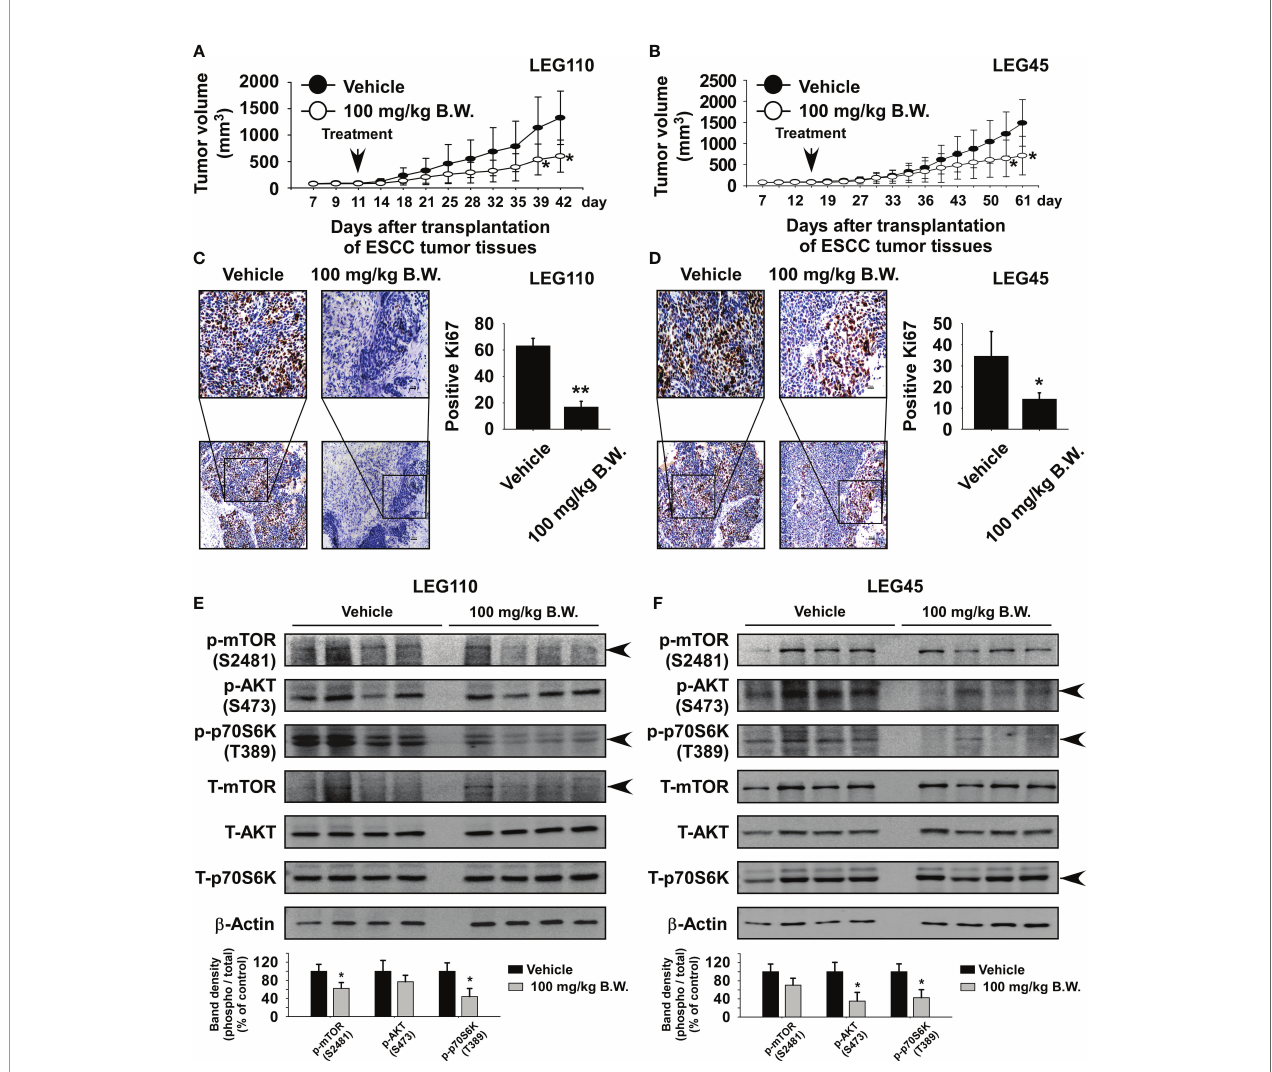
FIGURE 6 | Ethyl ferulate reduces esophageal squamous cell carcinoma (ESCC) patient-derived xenograft tumor growth in vivo. Mice were divided into two groups to assess the effect of ethyl ferulate on ESCC patient-derived xenograft (PDX) tumor growth. Groups are as follows: 1) vehicle group or 2) group treated with 100 mg/kg of ethyl ferulate. Tumor-bearing mice were orally treated (by gavage) with ethyl ferulate or vehicle for 32 (LEG110; n = 10) or 53 (LEG45; n = 7) days. Tumor volumes were measured on the days indicated. The effect of ethyl ferulate on ESCC tumor growth in (A) LEG110 or (B) LEG45 ESCC PDX tissues. For panels (A, B) , data are shown as mean ± SE from each group. The effect of ethyl ferulate on Ki-67 expression in (C) LEG110 or (D) LEG45 ESCC PDX tissues (n = 5). Three slices per PDX tissue were analyzed. Treated or untreated groups of tumor tissues were stained with antibodies to detect Ki-67 (×100; scale bar: 100 m m; ×20; scale bar: 50 m m). (E, F) Ethyl ferulate inhibits phosphorylated mammalian target of rapamycin (mTOR), p70S6K, and AKT protein expression in esophageal tumor tissues. Tumor tissues from each group were immunoblotted with antibodies to detect mTOR, p70S6K, and AKT and phosphorylated mTOR, p70S6K, AKT, and b -actin. b -Actin was used to verify equal protein loading. Band density was measured using the ImageJ (NIH) software program, and the results are shown as a bar graph. One-way ANOVA was used to compare signi fi cant differences. The asterisk (*) indicates a signi fi cant (* P < 0.05; ** P < 0.01) inhibitory effect of ethyl ferulate